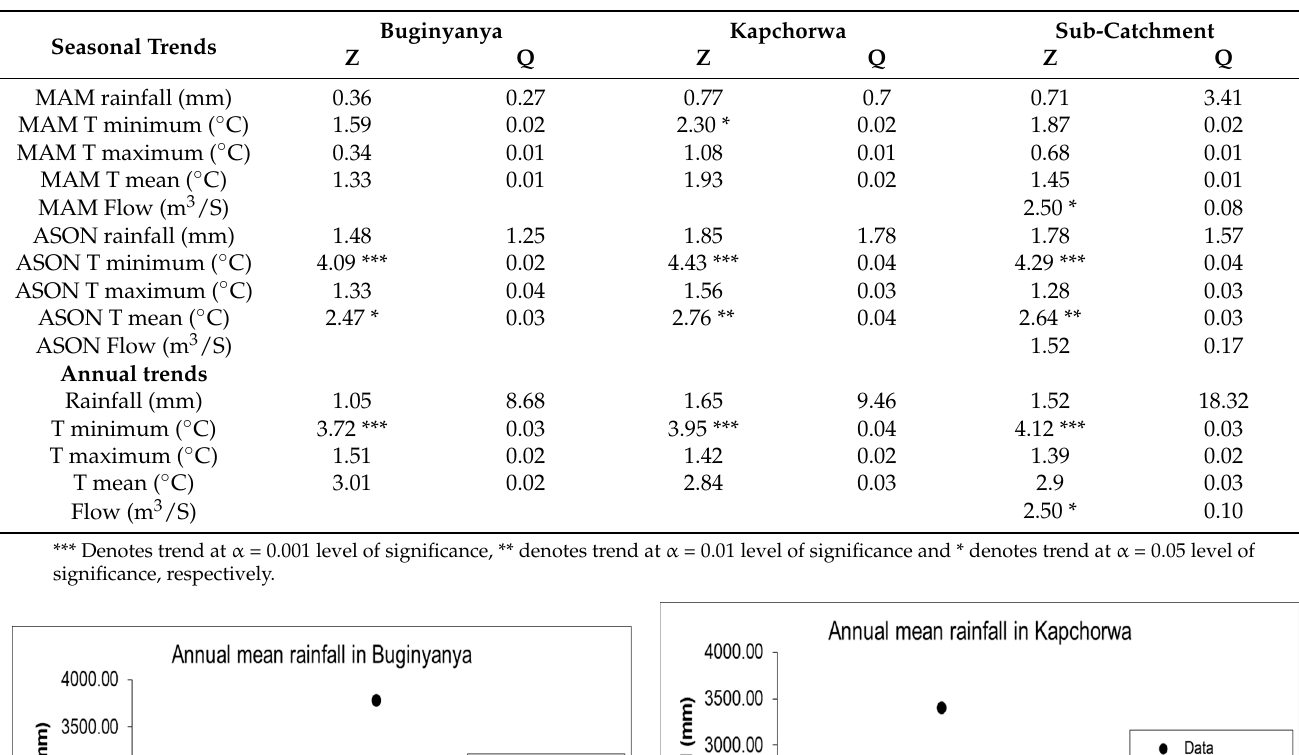
flow (Figure 9) increased at α = 0.05. A study by [39] also found minimal variation (less than 1 ◦ C) and a very similar CV below 5% between the average maximum and minimum temperature in MAM and ASON for Uganda. Table 6. Seasonal and annual trends of rainfall and minimum, maximum, and mean temperature (1981–2015) for Buginyanya, Kapchorwa, whole sub-catchment, and river flow (1998–2015).